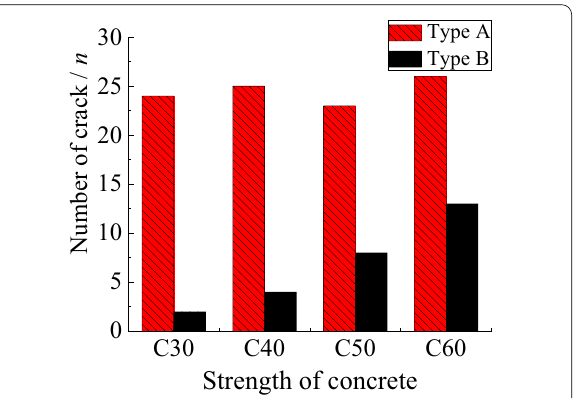
Fig. 7 The number of A and B type cracks varies with concrete